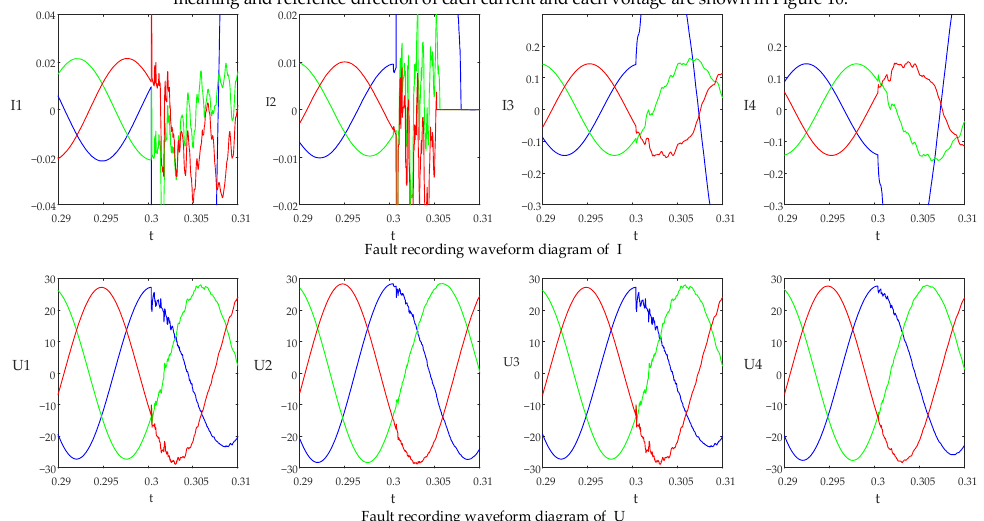
Figure 11. Fault recording waveform diagram s of CB4, CB5, CB6 and CB7.